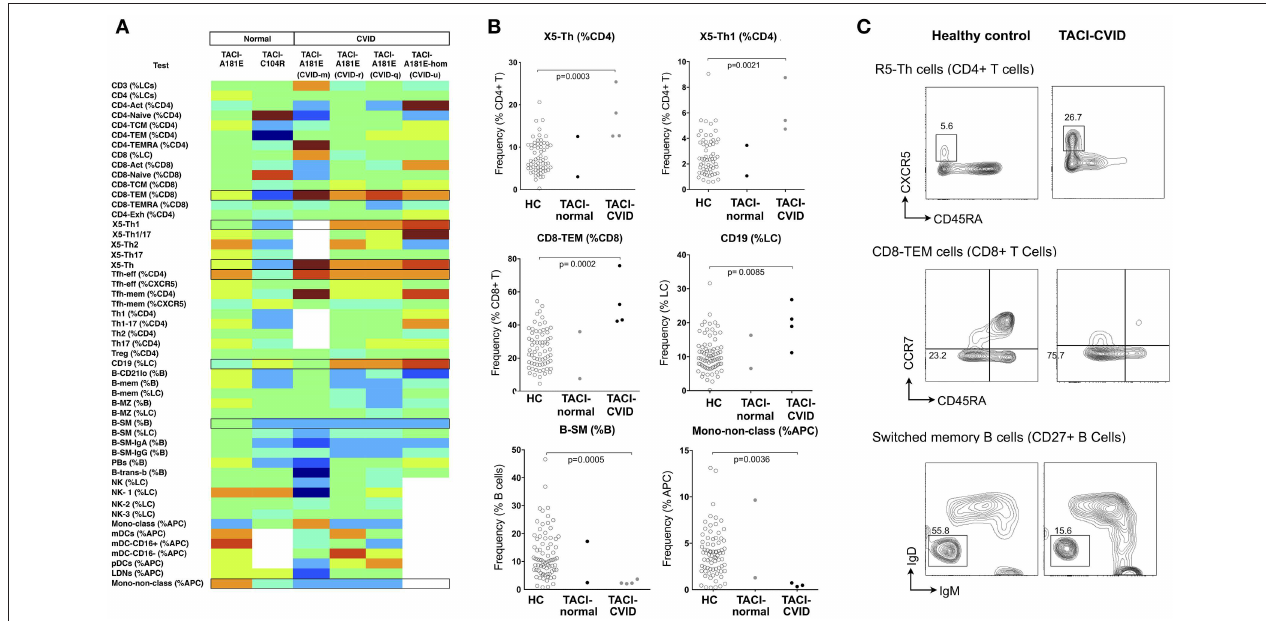
FIGURE 4 | Analysis of cellular parameters in CVID patients carrying TACI variants in comparison to TACI mutant control subjects without CVID. (A) Heat mapping with discontinuous shading for four unrelated CVID patients carrying the TACI A181E allele, one homozygous, along with two healthy individuals with A181E, or C104R alleles. Boxes highlight parameters for which cellular changes differ in those with CVID compared with TACI controls. (B) Scatter plots showing raw values for populations identified in (A) , along with representative FCM contour plots of these critical parameters (C) . Raw and centile data is presented in Supplementary Table 3